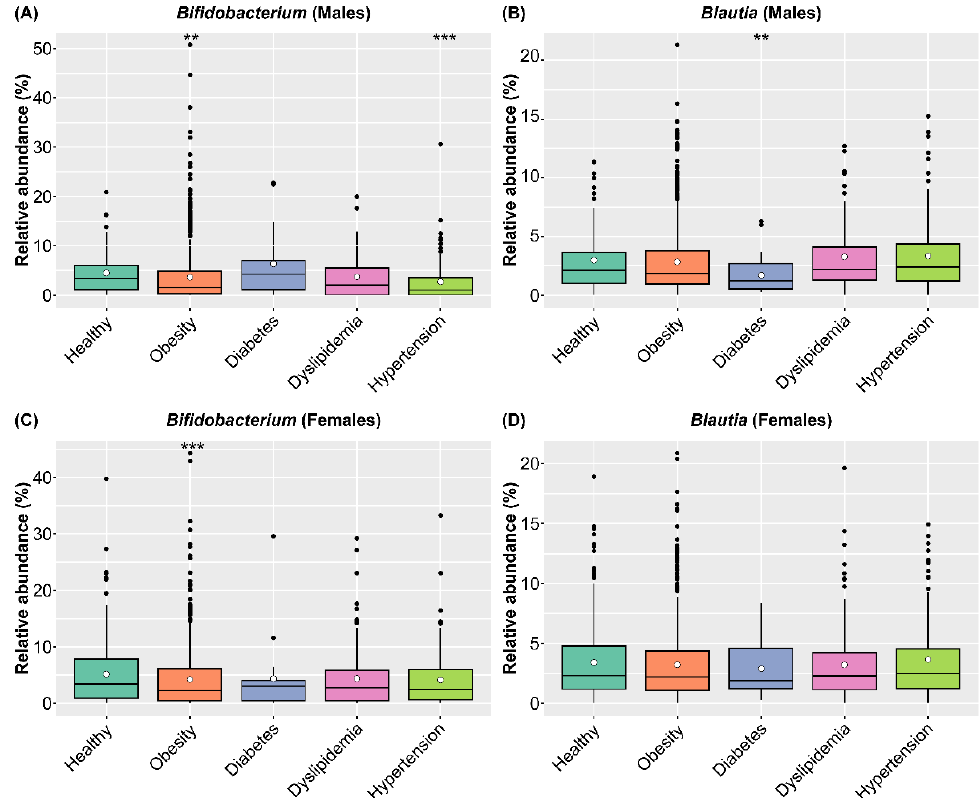
Figure 8. Relative abundance of Bifidobacterium and Blautia in healthy participants and participants with different diseases in the SymMAD database. ( A ) Relative abundance of Bifidobacterium in males. ( B ) Relative abundance of Blautia in males. ( C ) Relative abundance of Bifidobacterium in females. ( D ) Relative abundance of Blautia in females. Each dot represents an outlier. The abundance of each genus in healthy and sick participants was compared using the ALDEx2 pipeline. Obese participants of both sexes had significantly lower abundance of Bifidobacterium compared with healthy participants. In males, participants with hypertension had significantly lower abundance of Bifidobacterium compared with healthy participants, while participants with diabetes had significantly lower levels of Blautia compared with healthy participants. ** p < 0.01 and *** p < 0.001.